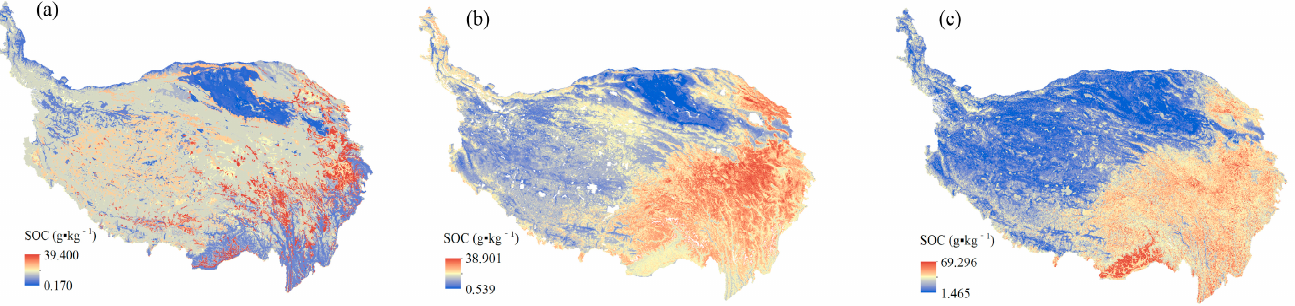
Figure 8. Comparisons of ( a ) HWSD, ( b ) Li’s prediction, ( c ) Our prediction, and ( d ) true color image. 5. Conclusions This study predicted the SOC spatial distribution of the QTP by using four different machine-learning models. The field-measured, Soil Information data (250 m), and Senti- nel-2 images were used as model input for training and testing.